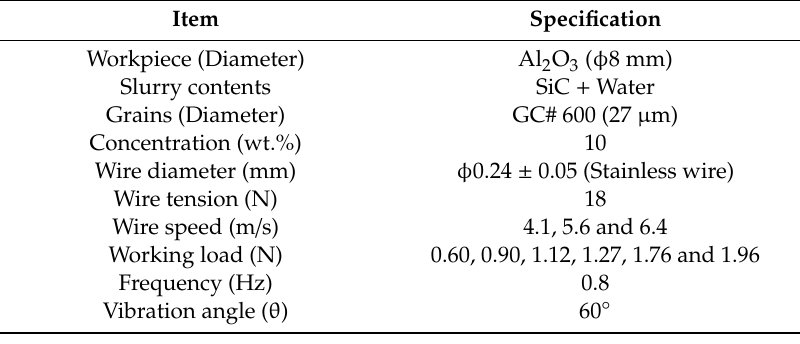
Figure 6. Model of a swinging wire-sawing. Table 1. Experimental conditions.